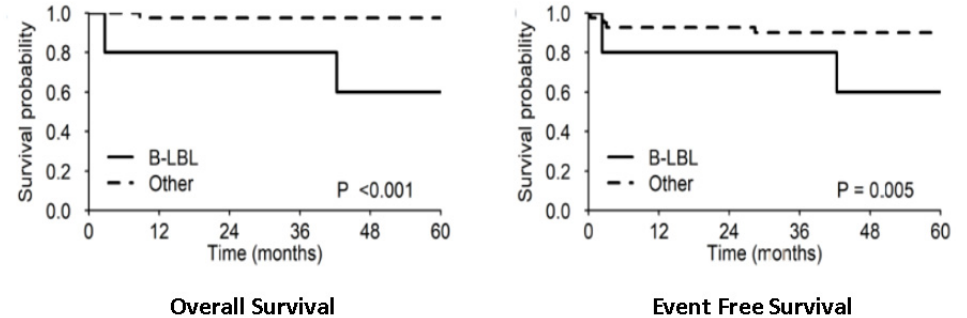
Figure 2. The 5-year OS/EFS rates in protocols I and II.